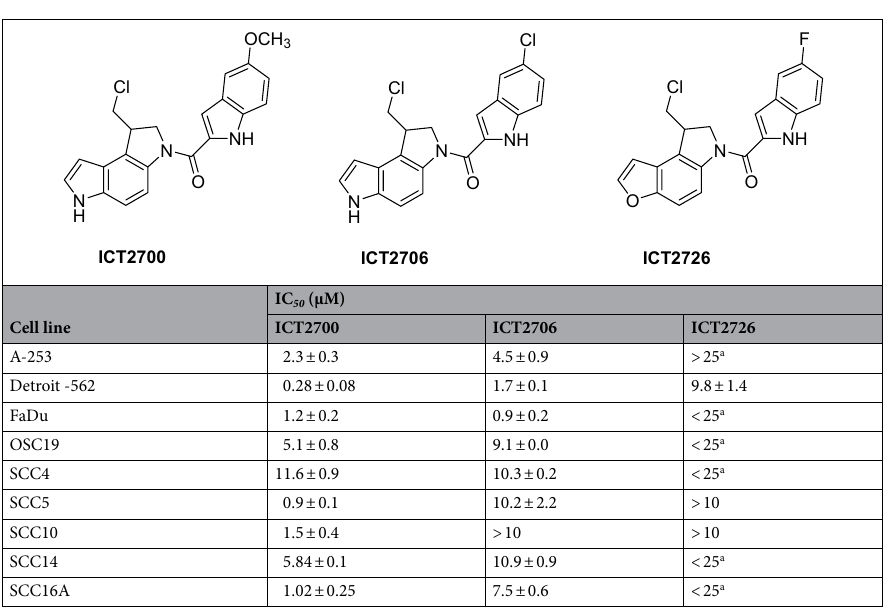
Table 2. Growth inhibition of duocarmycin compounds in HNC cell lines. a Not soluble above this